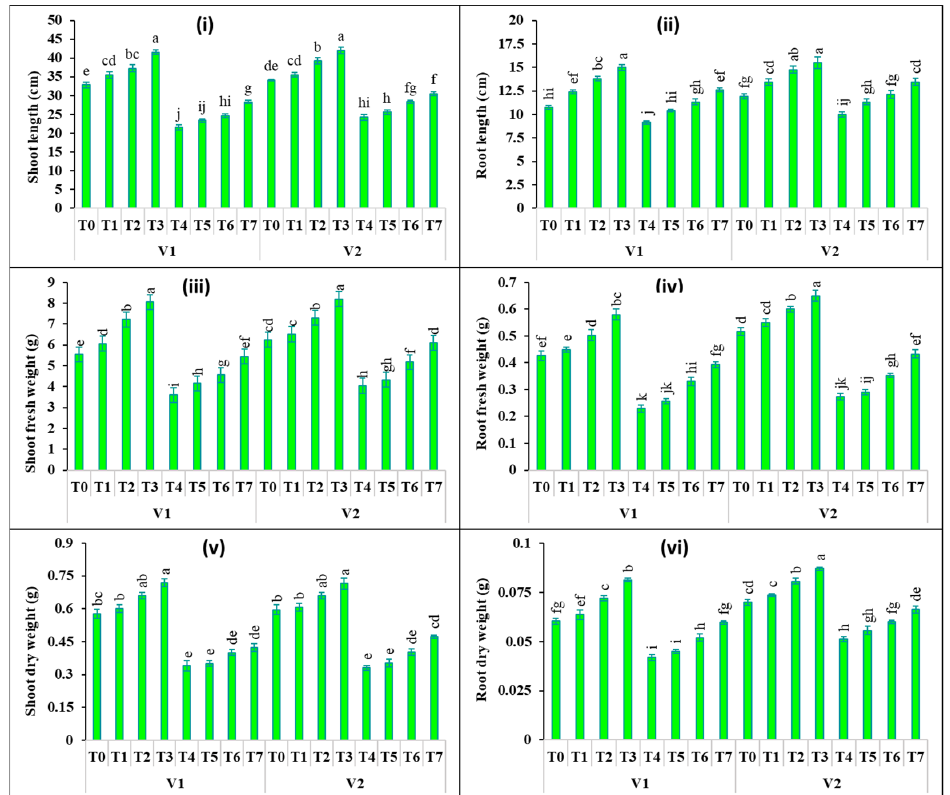
Figure 1. Influence of salicylic acid priming on ( i ) shoot and ( ii ) root length, ( iii ) shoot and ( iv ) root fresh weight, and ( v ) shoot and ( vi ) root dry weight under salt stress; T0 (control), T1 (hydropriming), T2 (10 mM SA priming), T3 (20 mM SA), T4 (170 mM NaCl), T5 (170 mM NaCl + hydropriming), T6 (170 mM NaCl + 10 mM SA priming), and T7 (170 mM NaCl + 20 mM SA priming); bars sharing same case letter or without lettering, for a parameter, do not significantly differ ( p ≤ 0.05) by the LSD